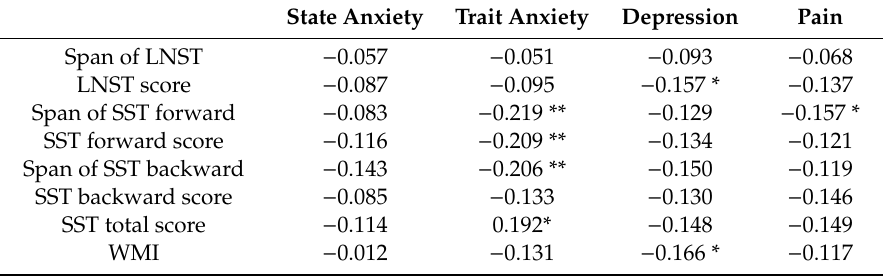
Table 4. Pearson correlations between the clinical questionnaire scores and neuropsychological measures. State Anxiety Trait Anxiety Depression Pain Span of LNST − 0.057 − 0.051 − 0.093 − 0.068 LNST score − 0.087 − 0.095 − 0.157 * − 0.137 Span of SST forward − 0.083 − 0.219 ** − 0.129 − 0.157 * SST forward score − 0.116 − 0.209 ** − 0.134 − 0.121 Span of SST backward − 0.143 − 0.206 ** − 0.150 − 0.119 SST backward score − 0.085 − 0.133 − 0.130 − 0.146 SST total score − 0.114 0.192* − 0.148 − 0.149 WMI − 0.012 − 0.131 − 0.166 * − 0.117 * p < 0.05; ** p <